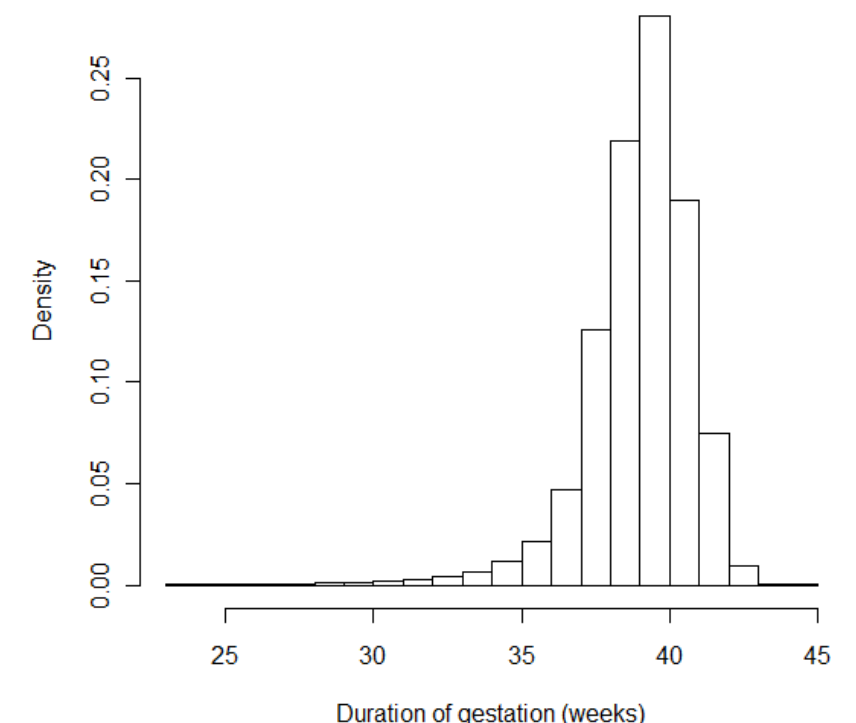
Figure 1. Histogram of duration of